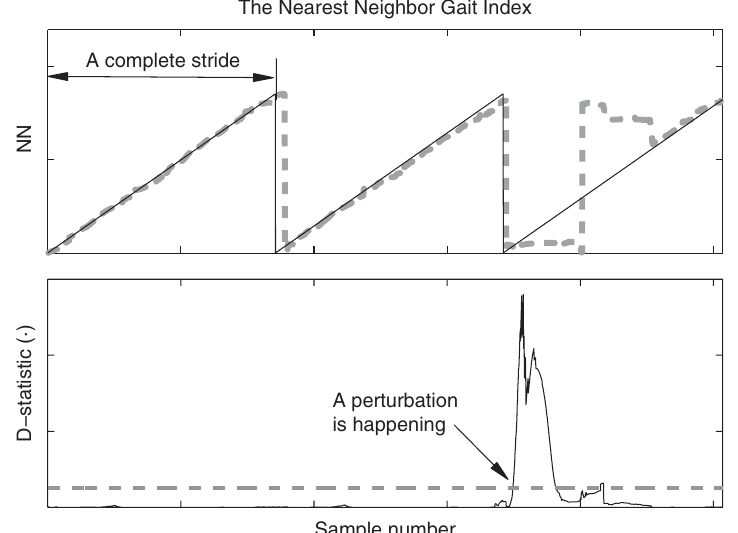
Fig. 3. An example of the execution of the proposed method. The upper panel shows the NNGI (dashed line) and the RLC (solid line). The lower panel shows the D-statistic (solid line) and its threshold D th (dashed